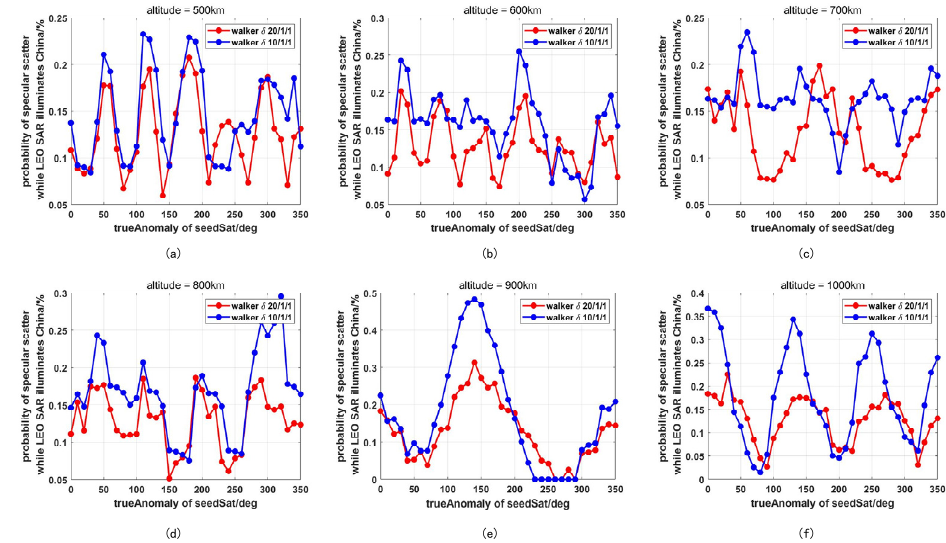
Figure A2. Probability of specular scatter while the LEO SAR is illuminating China changing with the true anomaly of the seed satellite. The red line represents the probability considering a LEO SAR constellation which uses a 20/1/1 walker pattern and the blue line represents the probability considering a LEO SAR constellation which uses a 10/1/1 walker pattern. ( a – f ) represent the altitude of 500 km, 600 km, 700 km, 800 km, 900 km, and 1000 km, respectively.